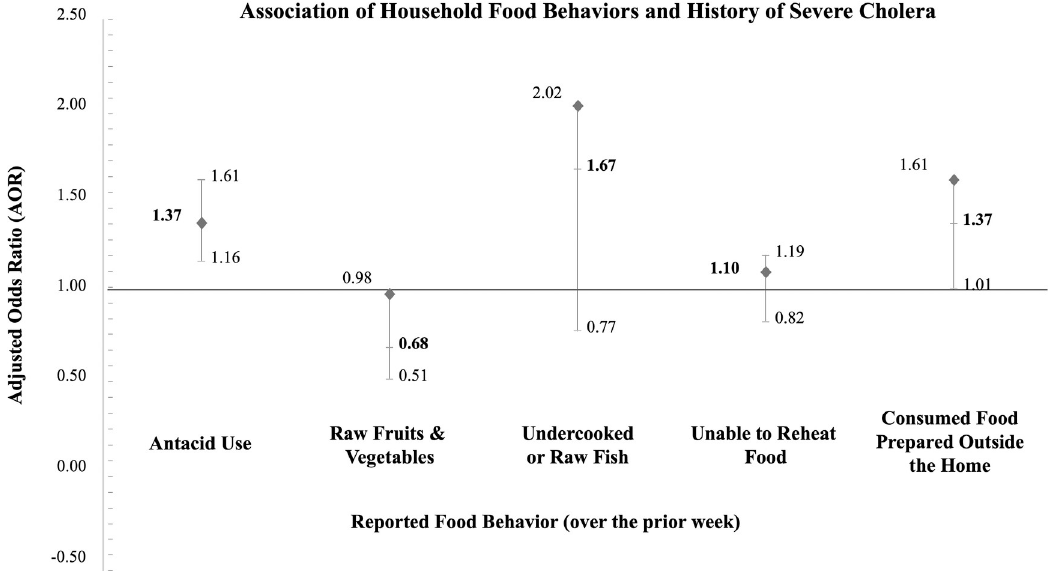
Fig 2. Adjusted associations of high-risk behaviors and history of severe medically-attended cholera in a cross-sectional study in Mirebalais, Haiti 2019 (N = 1072).